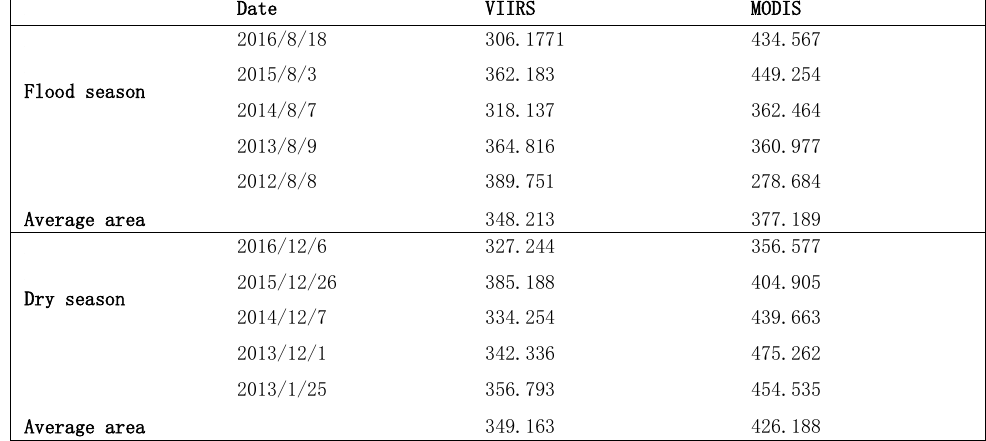
Table3: Extraction of Hong Lake’s area by VIIRS and MODIS in 2012~2016(units:km 2 ) statistics, during 2012~2016, the average area of Hong Lake is The average area of Hong Lake water extracted from VIIRS and MODIS is compared with that of Sun Chuang. It is found that changed little from 2012 to 2016. The trend of change in Figure VIIRS image extraction is more advantageous than MODIS when calculating area of water. From the Hong Lake surface area